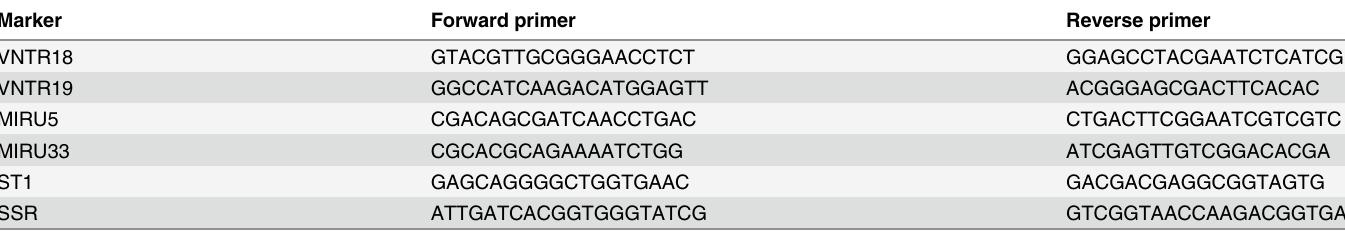
Table 2. Primer sequence for each VNTR marker ampli fi ed by nested PCR.